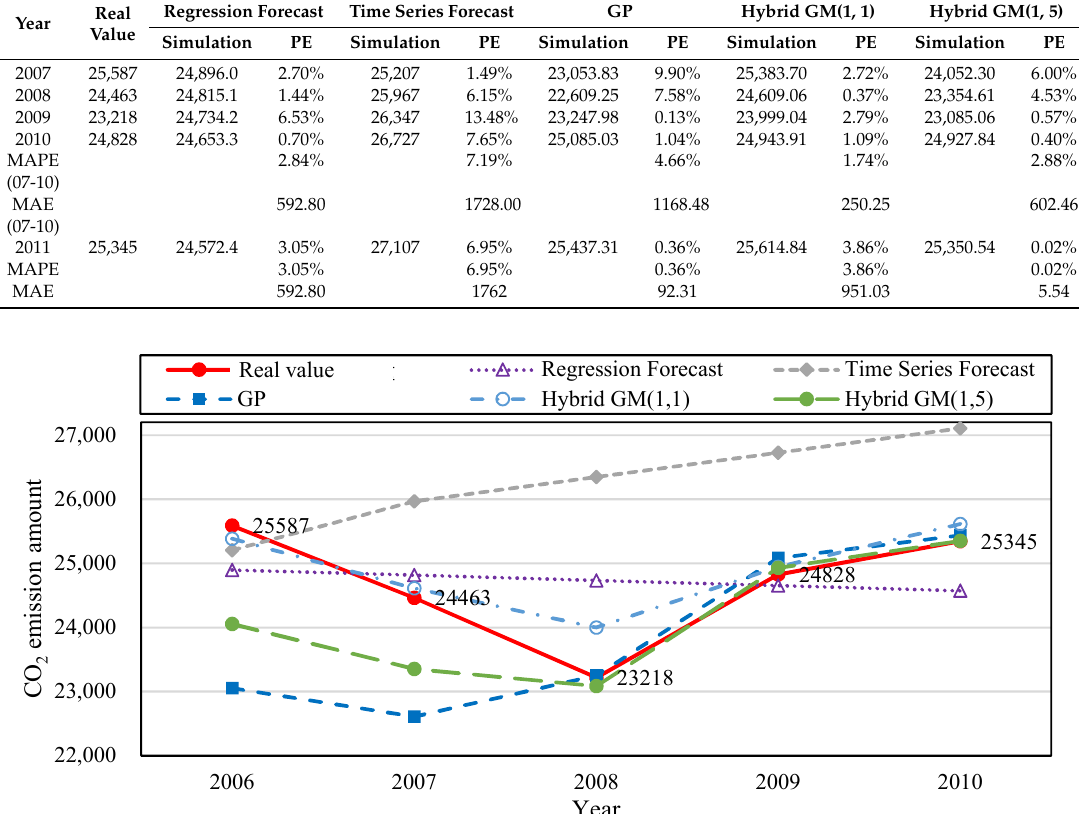
Figure 4. Comparison of the five forecast models trained with the data from 2007–2010 and tested with the data in 2011.